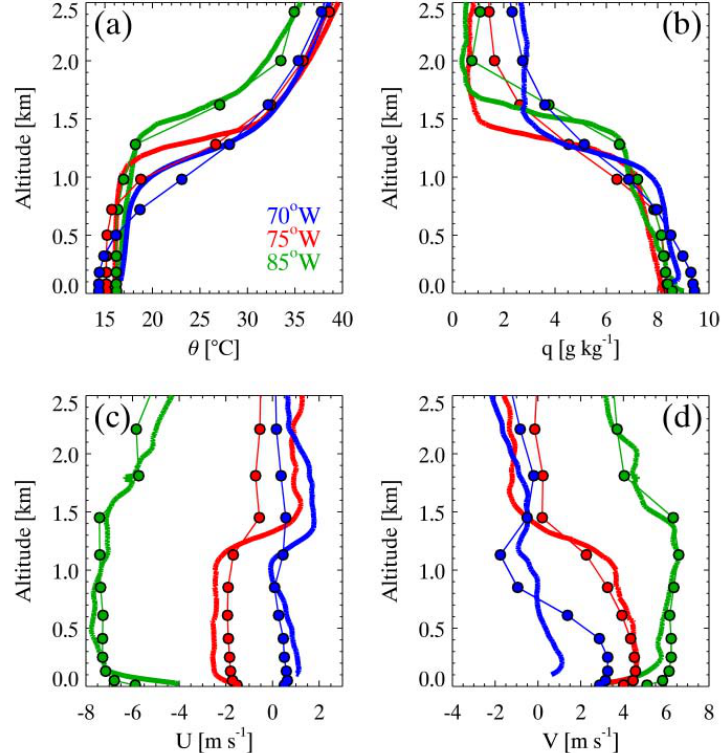
Fig. 2. Comparison of the mean measured (solid lines) and modelled (filled circles) profiles of (a) potential temperature, (b) specific humidity, (c) zonal wind and (d) meridional wind at various points along the 20 ◦ S latitude line. Observations at 75 ◦ W and 85 ◦ W are from the Ronald H. Brown research vessel and at 70 ◦ W from